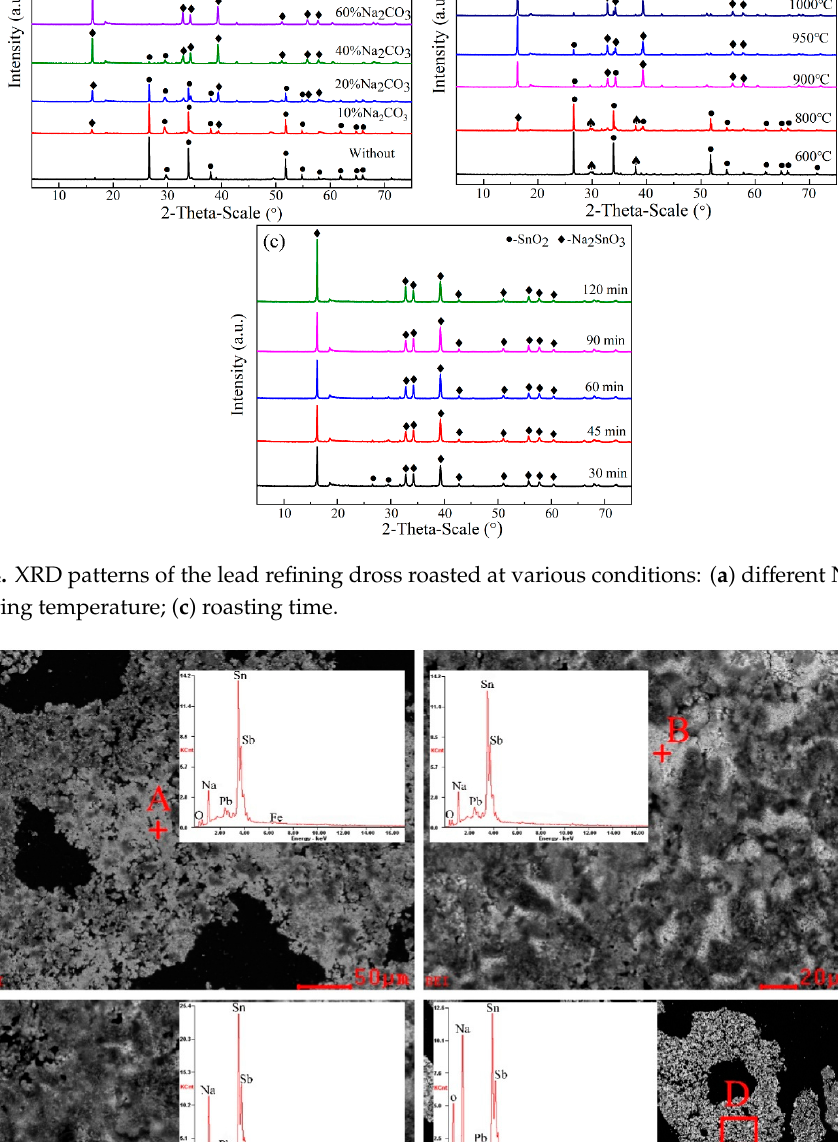
Minerals 2019 , 9 , 283 7 of 13